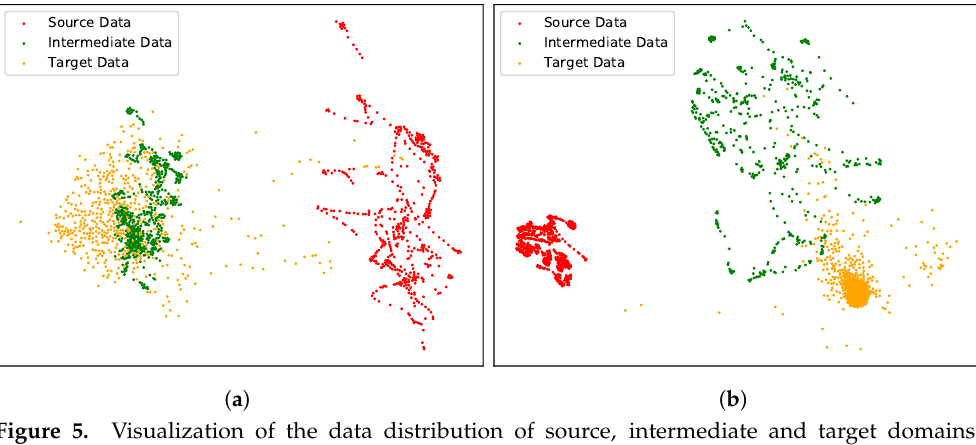
Figure 5. Visualization of the data distribution of source, intermediate and target domains. From every domain, 500 images are taken and their features represented as dots are extracted via t-SNE [57], where red, green and orange dots refer to the source, intermediate and target data respectively. ( a ) visual, ( b )